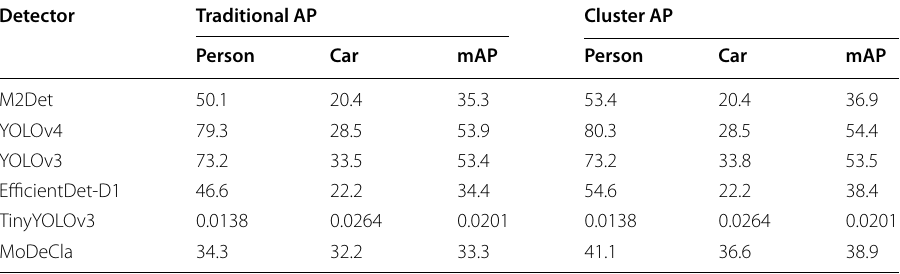
Table 6 AP values computed from the Traditional and Cluster precision-recall curves on the Winter benchmark